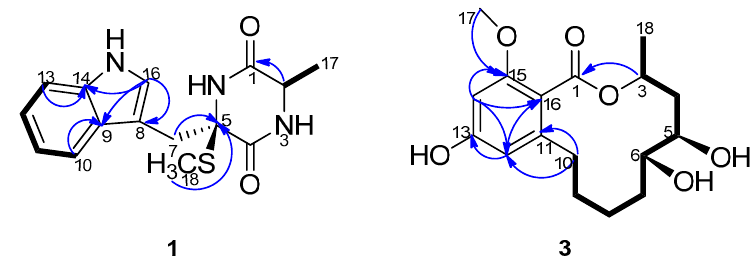
Figure 2. 1 H- 1 H COSY (bold line) and main HMBC (arrow) correlations of 1 and 3 .